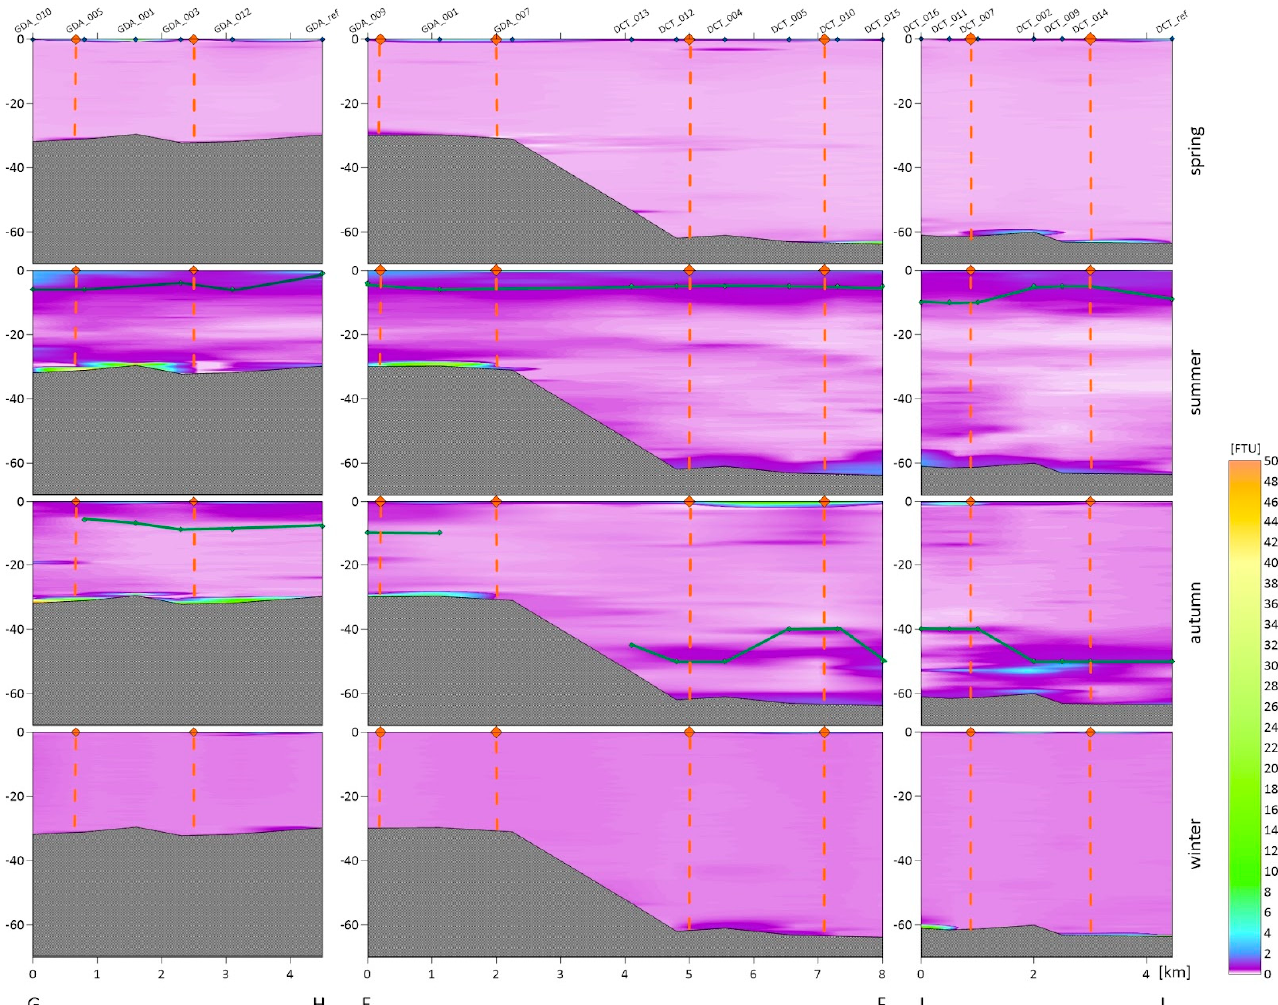
Figure 3. Vertical cross-sections of the turbidity of the seawater obtained based on the in situ measurements conducted along the GH, EF, and IJ sections. The orange points at the sea surface and dashed lines are the borders of the Gda ń sk and DCT dumpsites, the green line is the halocline, and the measurement points along the transects are marked in blue on the top axis.